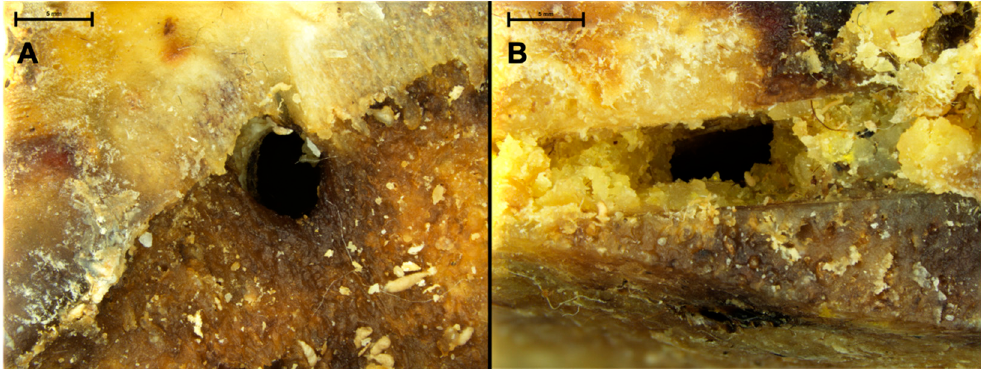
Figure 1. Close view of Bovidae fresh femoral head showing circular holes ( A ) and rectangular hole on a chop mark ( B ), both corresponding to pupation chambers dug into the decaying flesh and car- tilage.